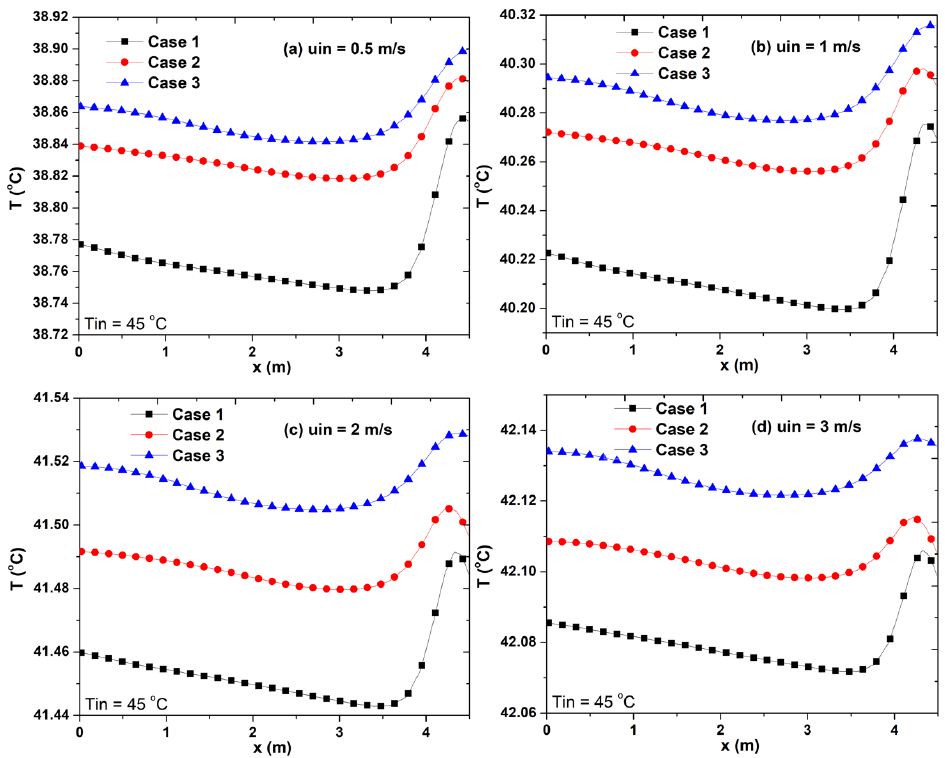
Figure 6. Temperature profiles in the room domain at y = 1 m for various inlet